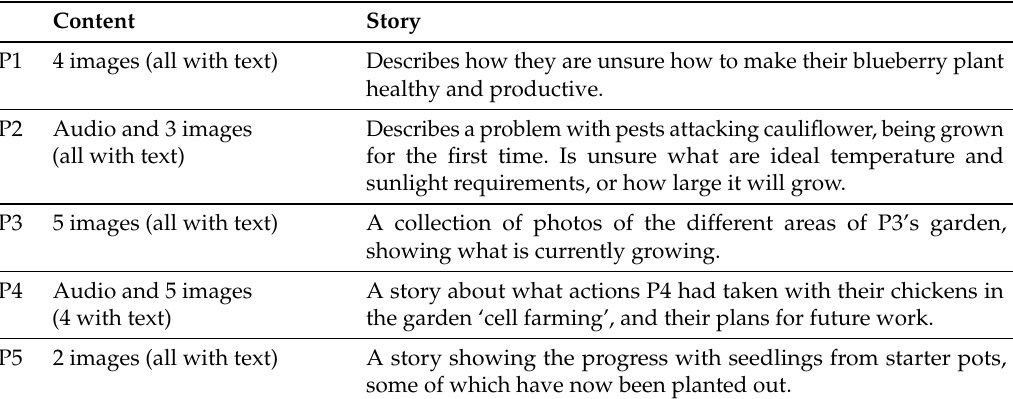
Table 2. Stories created by participants during interviews.